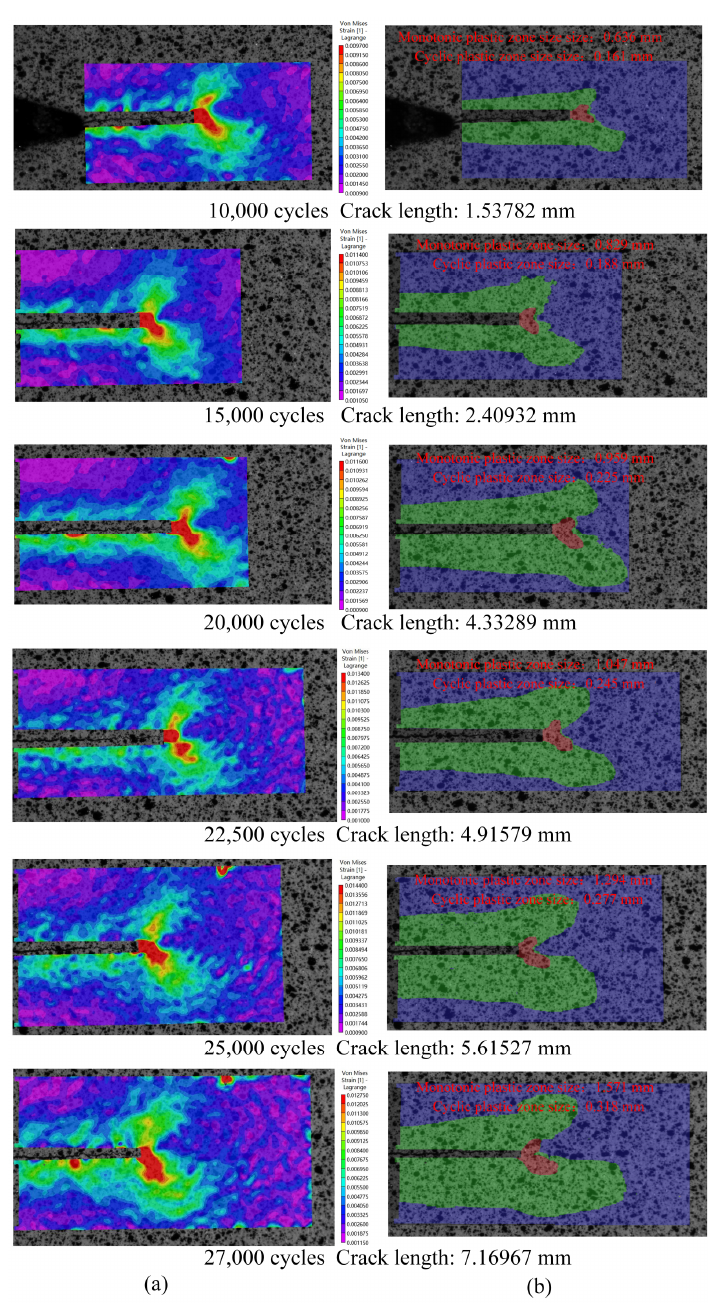
Figure 14. Measurement result: ( a ) Von Mises strain fields near the crack tip under maximum load points; ( b ) cyclic plastic zones near the crack tip under maximum load points of different crack lengths.